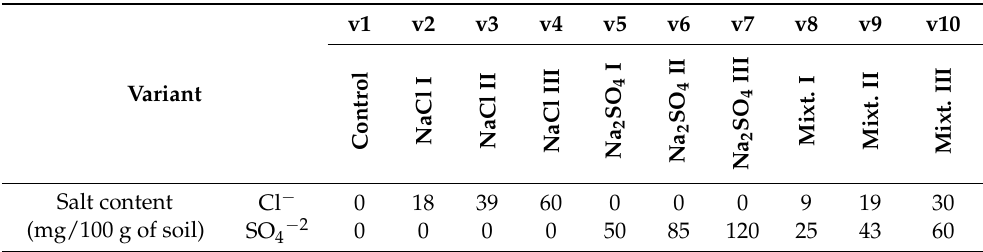
Table 1. Salt percentage in the experimental